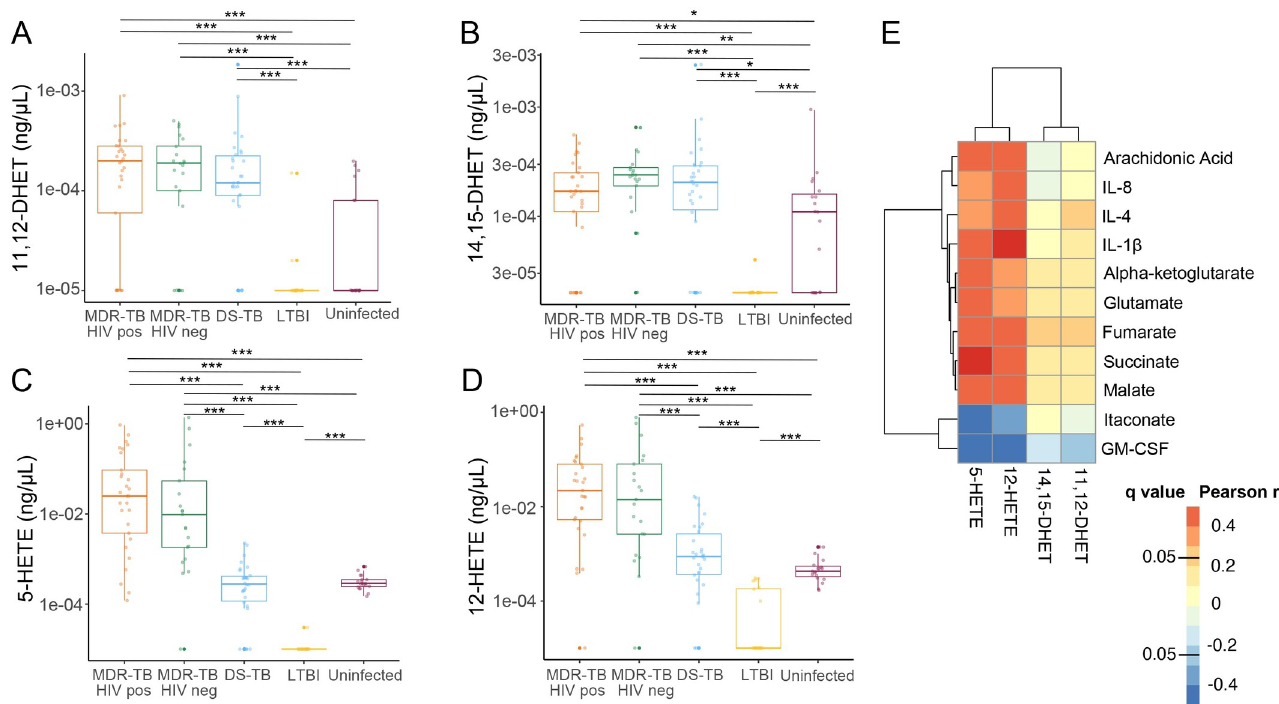
Fig 5. Immunometabolic remodeling is associated with proinflammatory eicosanoid signaling. Compared to persons with LTBI (yellow; n = 20) and persons without LTBI or TB disease (n = 19), persons with multidrug resistant (MDR)-TB with (orange; n = 29) and without (green; n = 21) HIV co-infection, as well as persons with drug susceptible (DS)-TB (blue; n = 30) demonstrated significant increases in plasma concentrations of the arachidonic acid metabolites (A) 11,12-DHET and (B) 14,15-DHET metabolized by the CYP450 system. Proinflammatory eicosanoids including (C) 5-HETE and (D) 12-HETE produced by lipoxygenase metabolism of arachidonic acid were significantly increased in persons with MDR-TB versus persons with DS-TB, LTBI and uninfected controls. (E) Shows a heatmap of metabolites and cytokines correlated with plasma concentrations of 5-HETE, 12-HETE, 11,12-DHET, and 14,15-DHET with dark red indicating a higher Pearson correlation coefficient and dark blue indicating a more negative correlation. Groups were compared using the Wilcox rank sum test: � p < 0.05, �� p < 0.01, ��� p < 0.001.